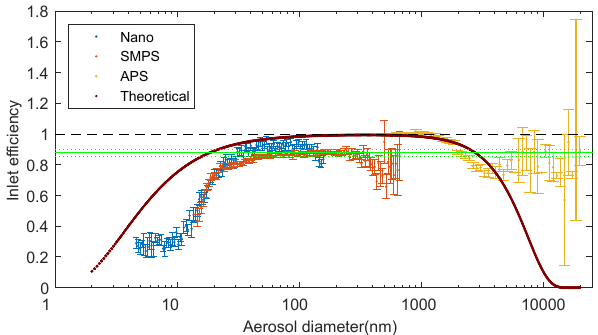
Figure A1. Median (with respect to 1000 bootstrap sub-samples) aerosol inlet efficiencies as a function of aerosol diameter (log scale) from three different instruments used to cover the size range of 4nm–20µm, together with theoretically calculated efficiencies. The three instruments used were: scanning mobility particle sizer (SMPS) for the smallest aerosol sizes (referred to as Nano), a stan- dard size range SMPS (SMPS in legend) and an Aerodynamic Par- ticle Sizer (APS). Error bars represent 2 standard deviations calcu- lated from the median absolute deviation of bootstrap sub-samples. The horizontal lines represent the overall IE with calculated 2 σ er- ror bars, with the black line a 100% efficiency reference